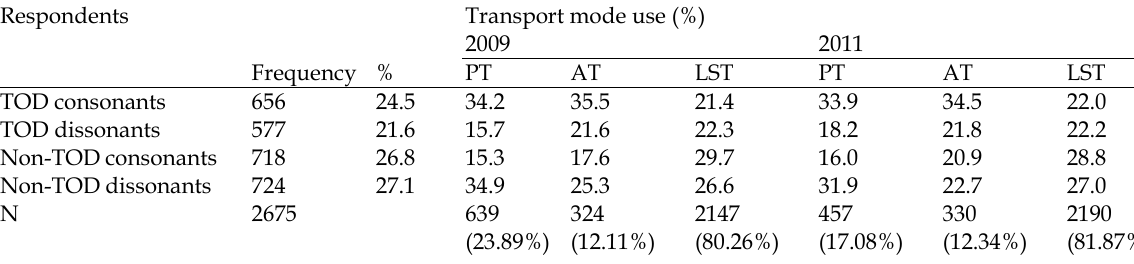
Table 3. Descriptive statistics showing the choice of travel mode to work